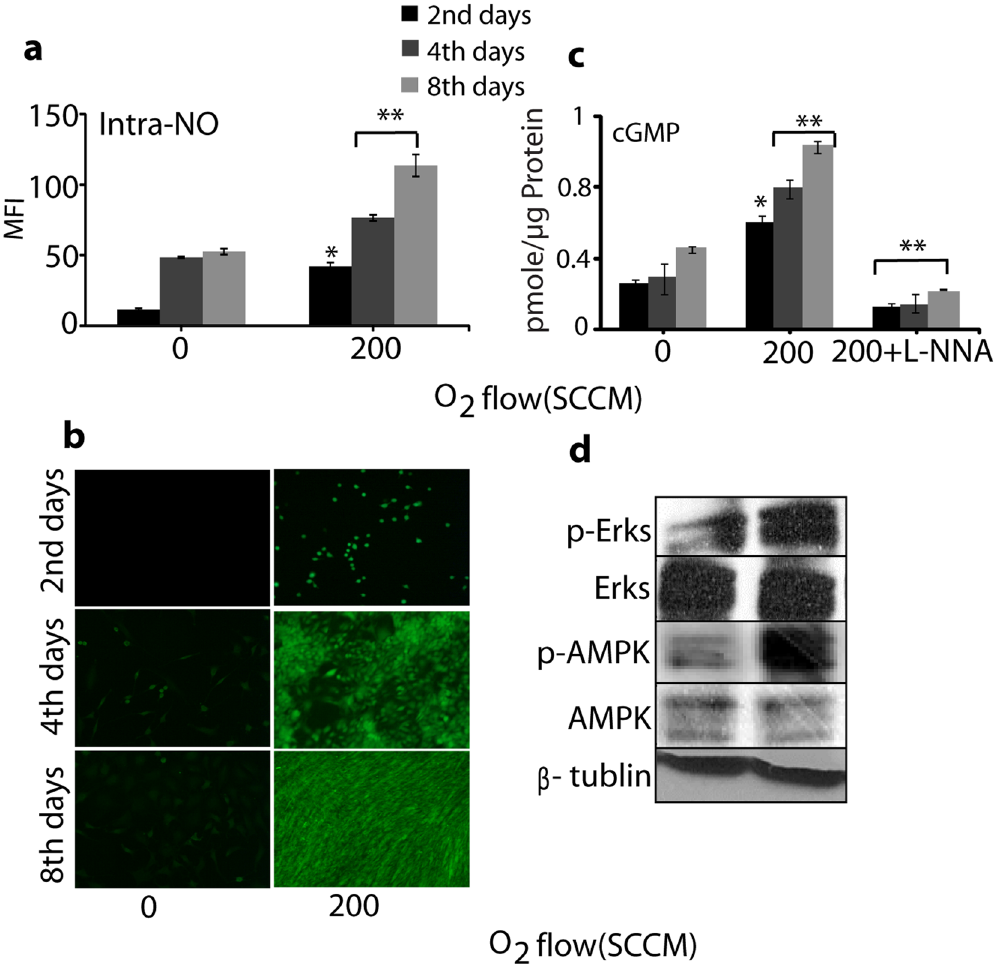
Figure 6. Intracellular NO and oxidative markers analysis. ( a ) Level of intracellular NO, ( b ) Fluorescence image of intracellular NO (200 of O 2 flow rate) for 3 min with on day 2, day 4, and day 8 ( c ) cGMP analysis after exposure with NO (200 of O 2 flow rate) for 3 min with and without the presence of L-NNA on day 2, day 4, and day 8. Each value is the average of three technical replicates. Students t-test was performed as the control ( * denotes P < 0.05 and ** denotes P < 0.01), ( d ) Western blot analysis of the Erks and APMK phosphorylation on 8 th day after exposure with NO (200 of O 2 flow rate) for 3 min. β -tublin was used as the loading